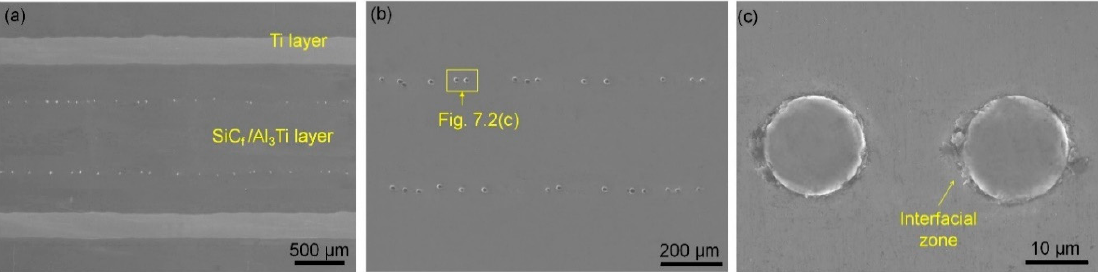
Figure 11. SEM micrographs of the Ti-(SiC f /Al 3 Ti)-laminated composite: ( a ) laminated structure, ( b ) SiC f /Al 3 Ti zone, and ( c ) interfacial zone.